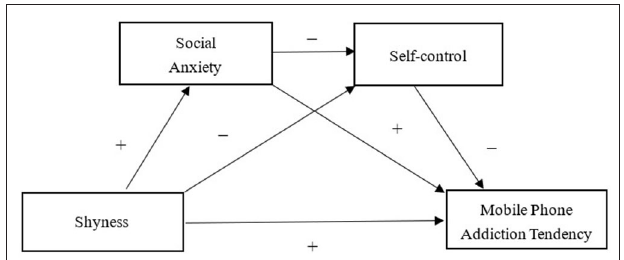
FIGURE 1 | A conceptual model of multiple mediator framework in which social anxiety and self-control mediate the relationship between shyness and mobile phone addiction